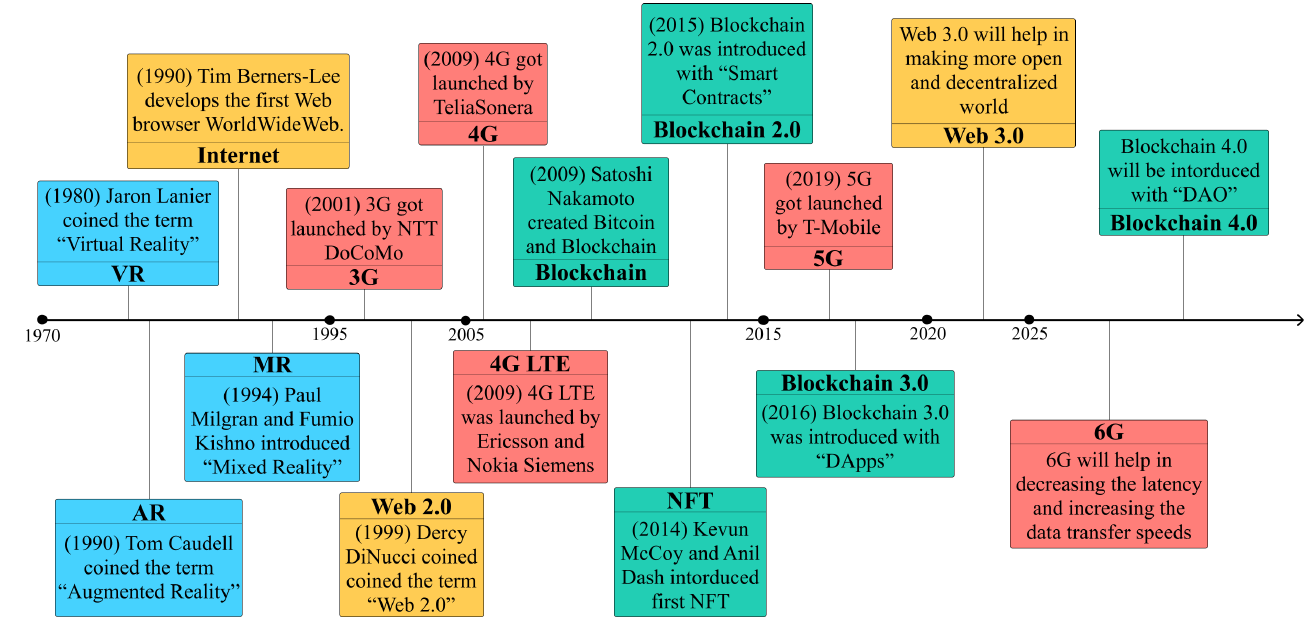
Figure 3. Timeline showing the emergence of Metaverse assistive